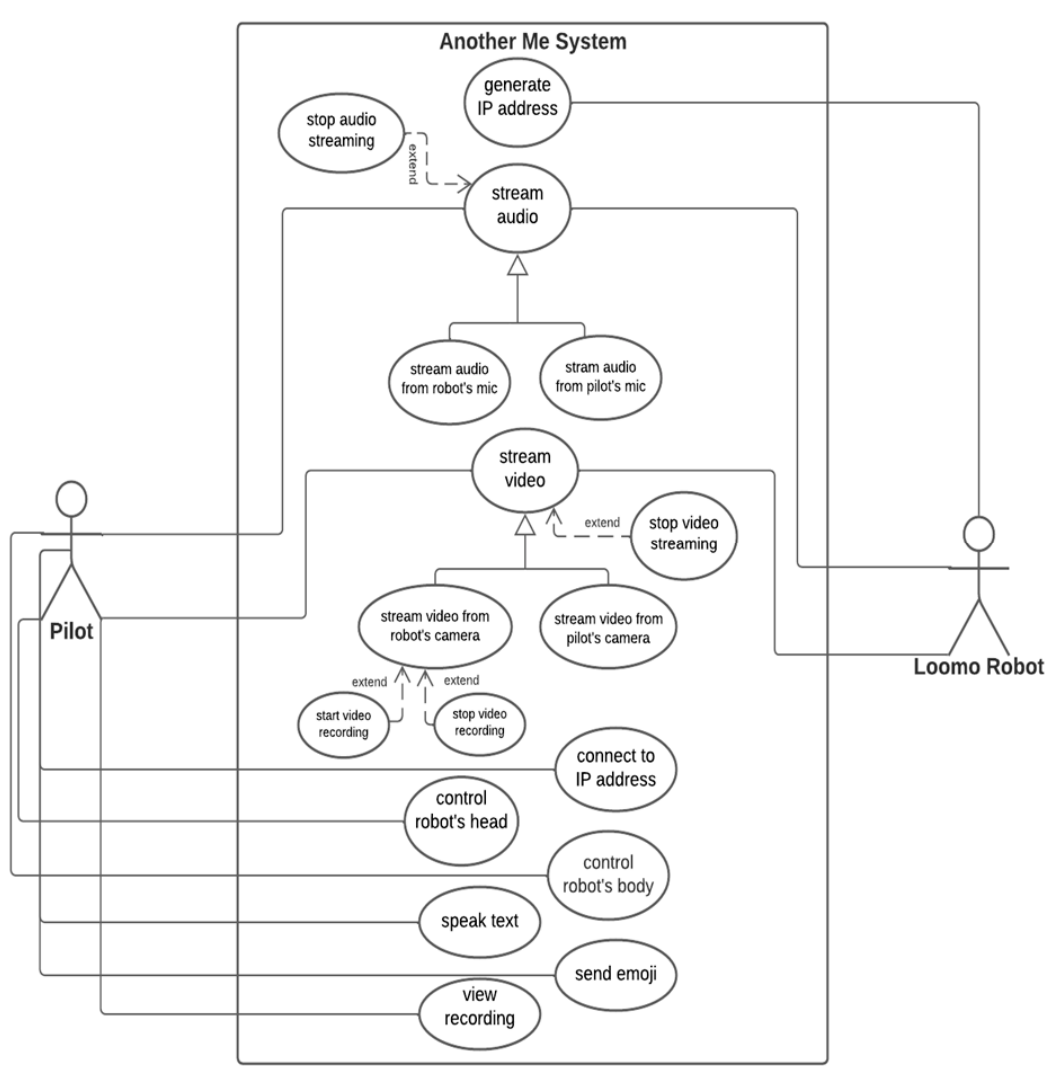
Figure 4. System components of the proposed MRP system.